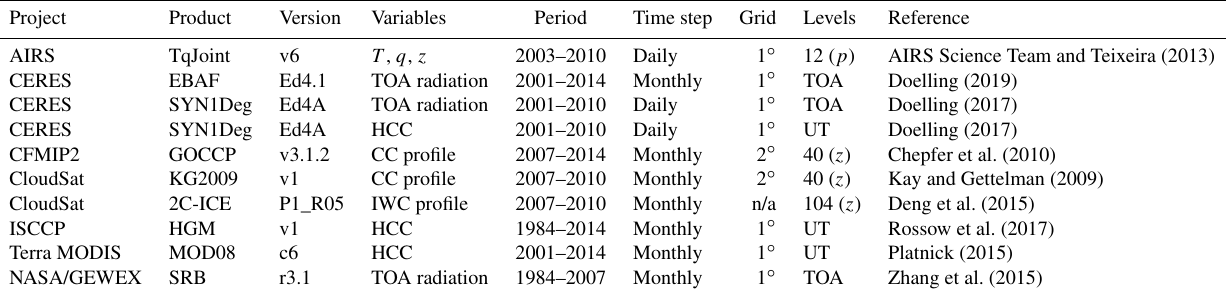
Table 2. Summary of observational data sets, listed in alphabetical order by project. TOA stands for the top of the atmosphere, and UT stands for upper troposphere, where the latter comprises pressures less than 500hPa for CERES SYN1Deg and pressures less than 440hPa for ISCCP and MODIS. Other abbreviations are defined in the text. n/a: not applicable.